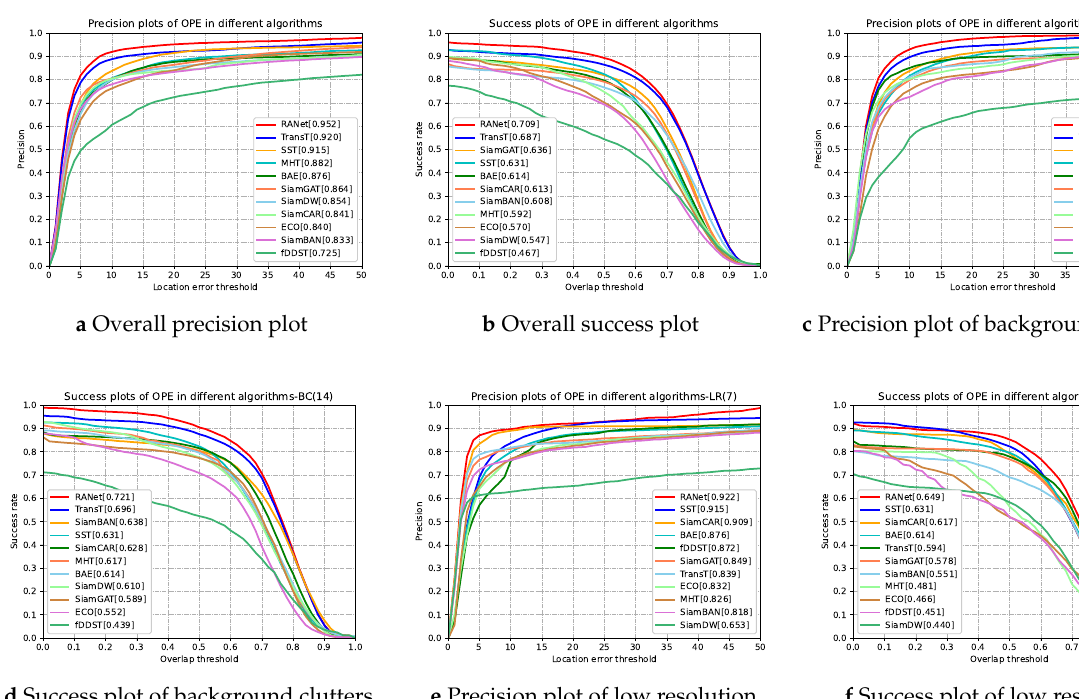
f Success plot of low resolution